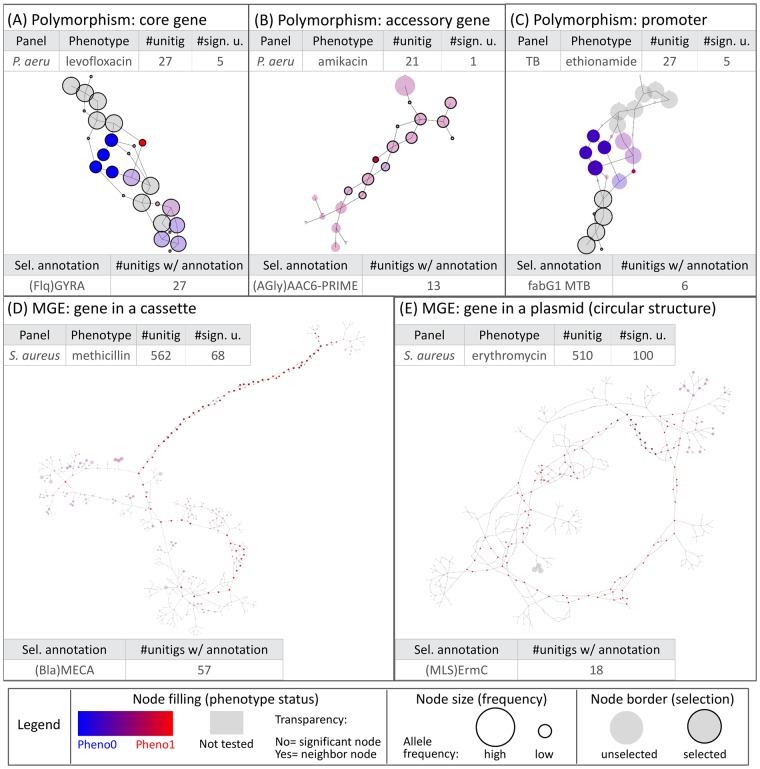
Different types of genetic events identified by DBGWAS.Each subgraph represents a distinct genetic event. Colours are continuously interpolated between blue for susceptible unitigs and red for resistant ones. Untested unitigs, present in > 99% or < 1% of the strains, are shown in grey. Nodes found to be not significative are shown with a transparency degree. The node size relates to its allele frequency: the larger the node, the higher the allele frequency. Circled black nodes map to annotated genes. The two tables in each panel provide information on the sugraph nodes. As an example, the subgraph in panel (A) is composed of 27 unitigs, 5 of which were significantly associated with resistance. All unitigs of this subgraph mapped to the gyrA gene. The subgraphs presented in the four other panels correspond to the top subgraphs (with lowest minq) obtained for different panels/phenotypes. All subgraphs are snapshots taken from DBGWAS interactive visualisation and are available online.